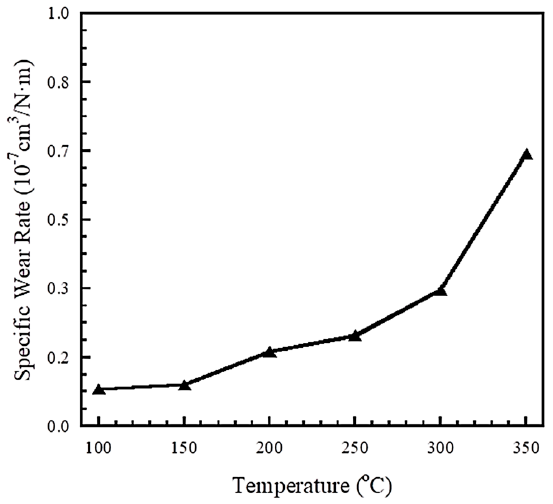
Figure 9. Specific wear rate as a function of the temperature of F-BA-a composite.